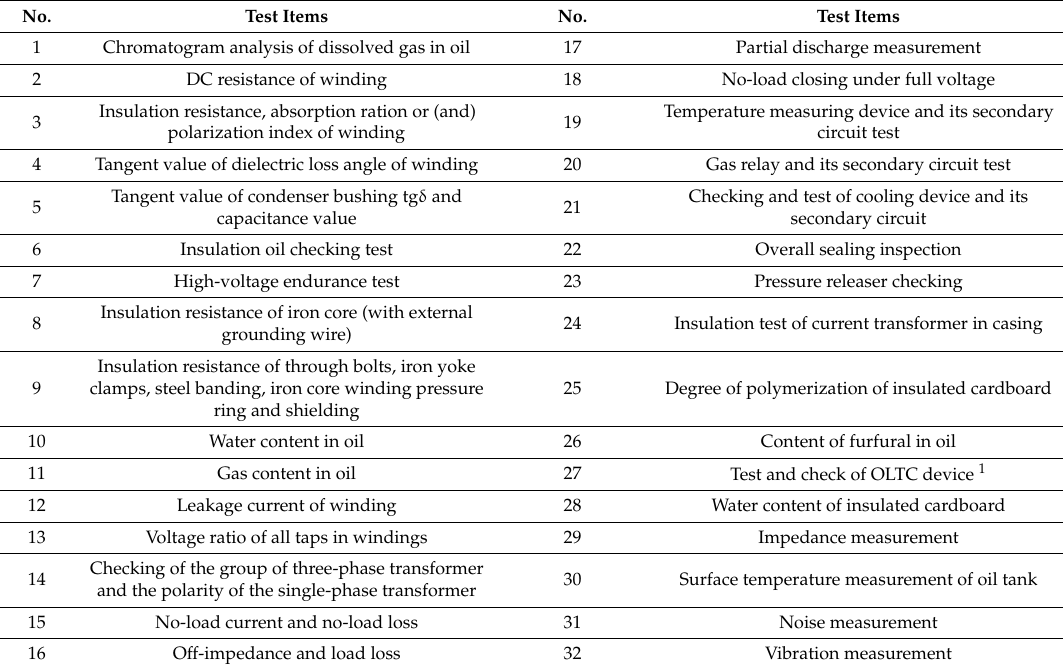
Table 1. Prescribed preventive test of insulation